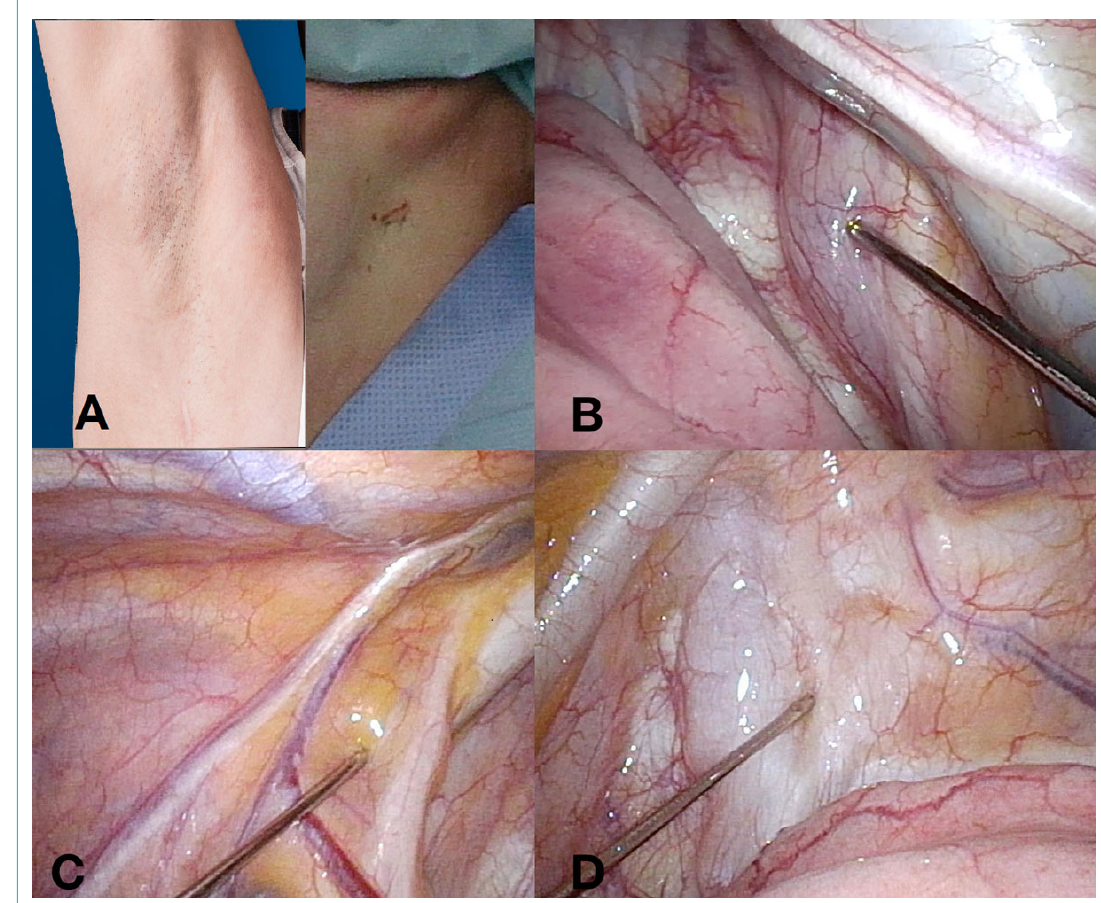
Figure 1: A: axillary single incision on the right side one year after the operation (right) and on the left side just after skin suture (left). B: local anaesthesia for vagal nerve on the right side. C: local anaesthesia for vagal nerve on the left side. D: local anaesthesia for parietal pleura on the left